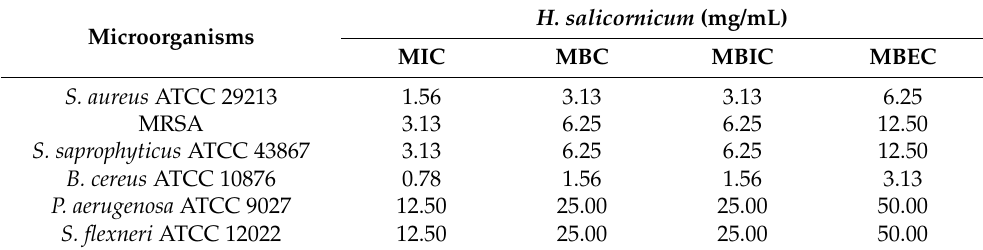
Table 5. MIC, MBC, MBIC, and MBEC results of H. salicornicum